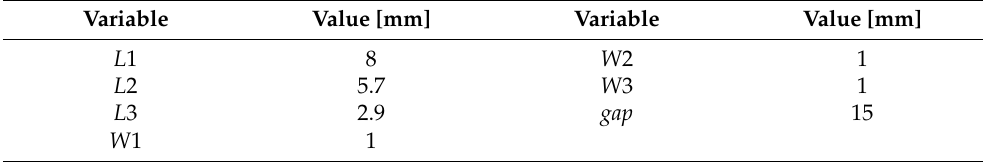
Figure 5. Combining two ZORs through the gap for coupling: ( a ) structure ( b ) S 11 and S 21 vs. gap. Table 5. The values of the physical dimensions of the second-order filter.